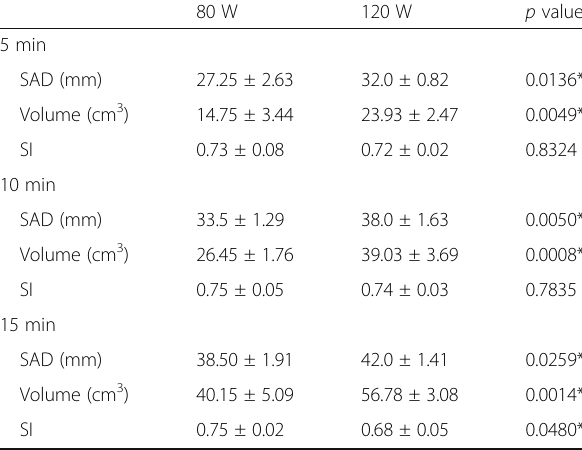
Table 2 Comparison of the 24 ablation results at 80 W